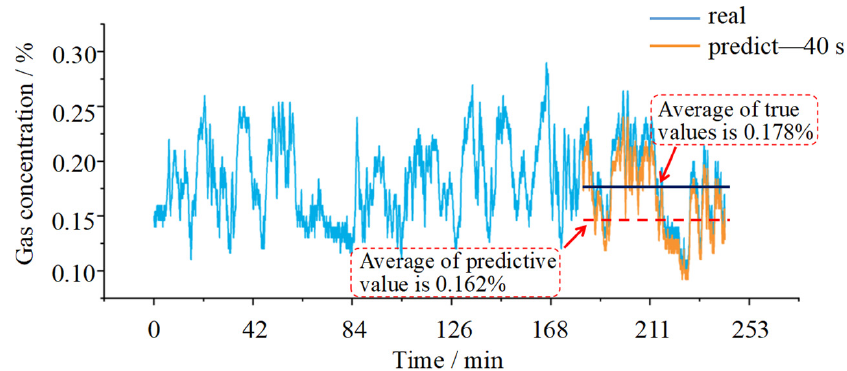
Figure 9. Gas concentration prediction of the model with an update period of 40 s.